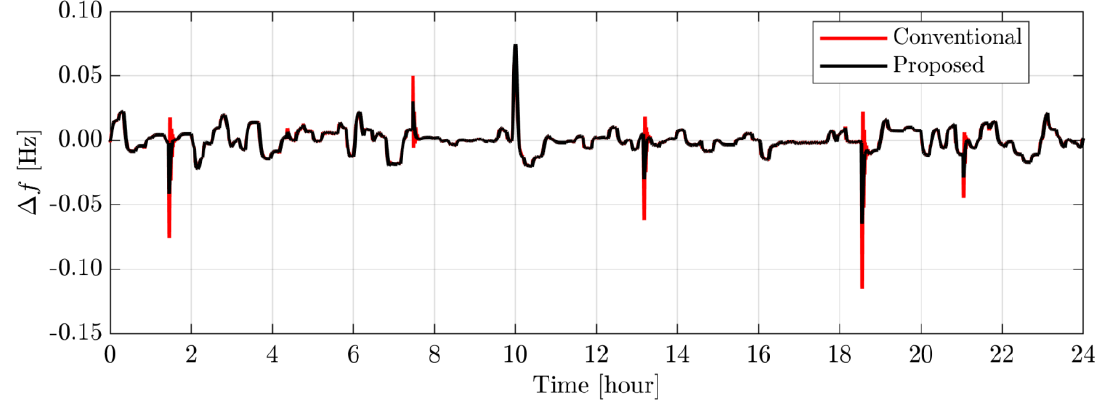
Figure 21. System frequency deviation of the studied µG for the scenario C.